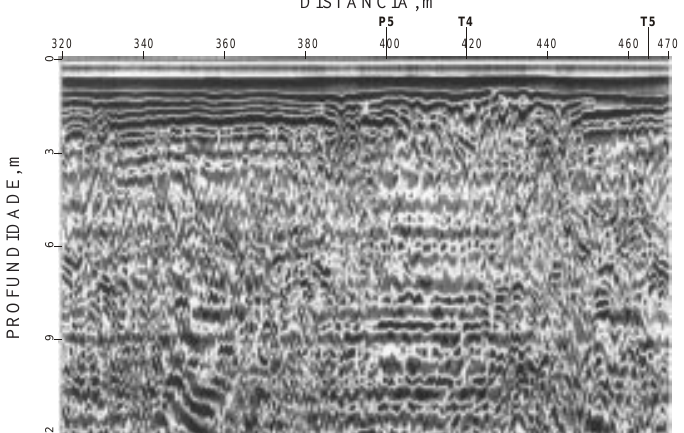
Figura 4. Radargrama - R3 mostrando sistema complexo de passagem de solos do tipo Espodossolo com duripã (320-346 m) para Espodossolo com pã muito degradado (346-364 m), gradando para um Argissolo Acinzen- tado com pã (P5 em 400 m) e para um Latossolo Amarelo entre 400-428 m (tradagem T4 em 420 m). A área entre 428-450 m volta a apresentar padrão de Argissolo Acinzentado sem pã e a partir de 450 m volta o refletor forte, mostrando o domínio do Argissolo Acinzentado com duripã (tradagem T5 em 465